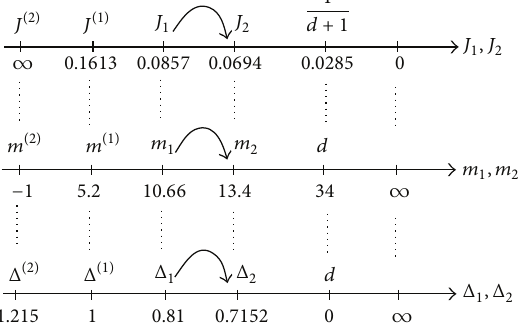
Figure 5: Deviations in the characteristic